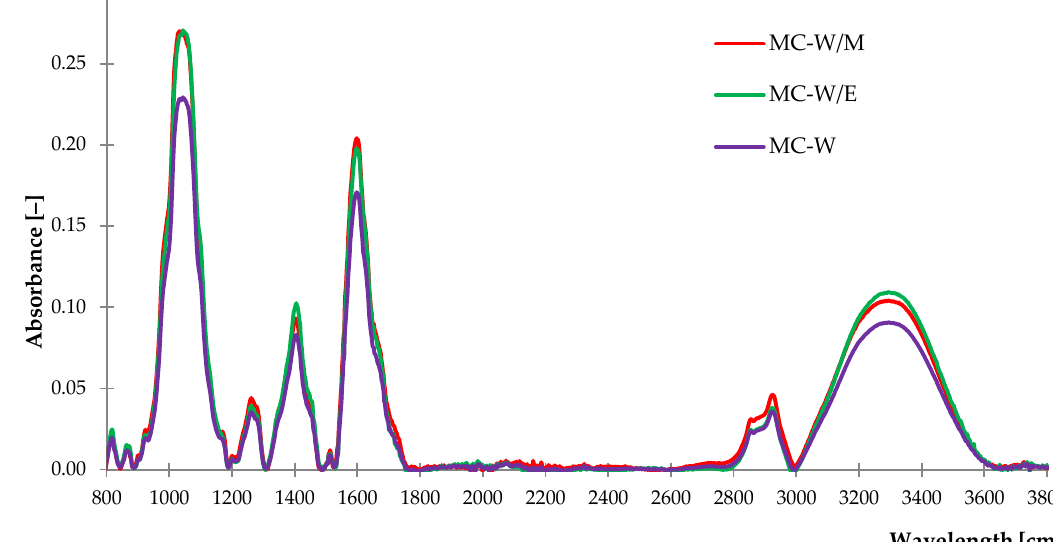
Figure 1. The FTIR spectra of German chamomile freeze-dried extracts.